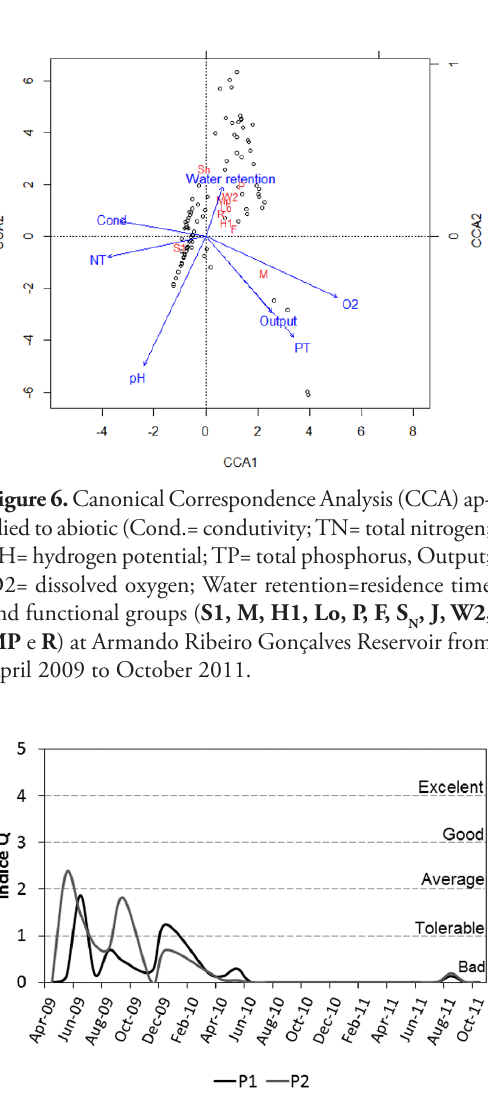
Figure 7. Variation of Q index in points 1 and 2